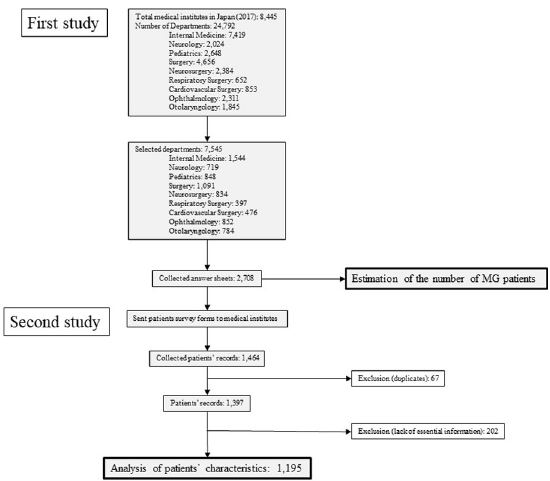
Fig 1. Flow chart of the epidemiological sturdy 2018. The study comprises the first survey and the second survey.